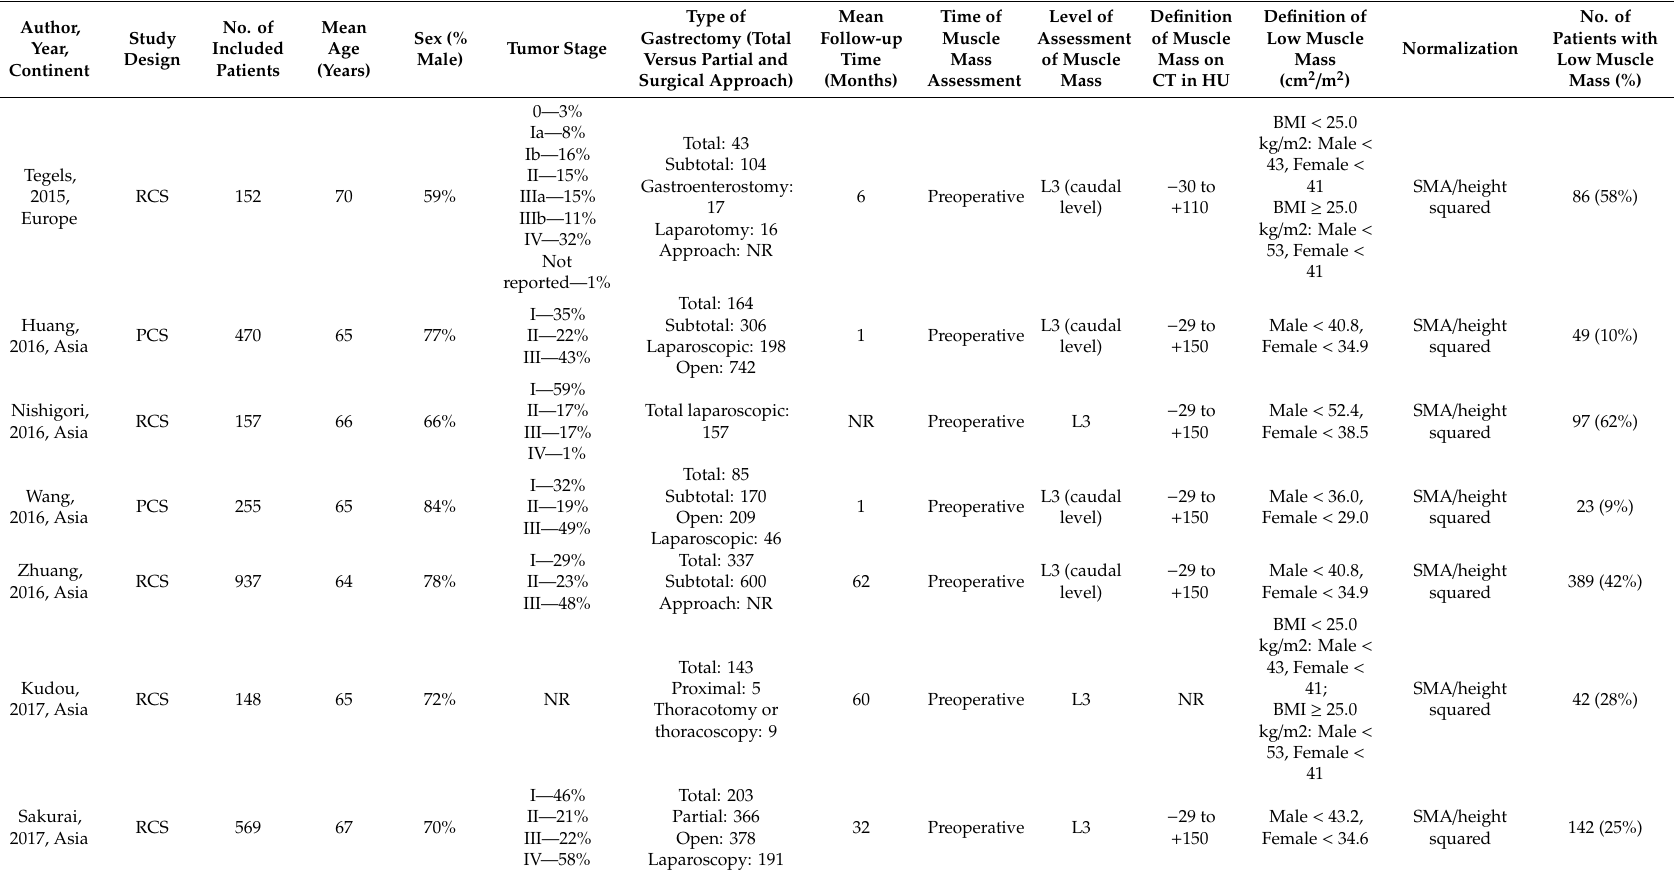
Table 1. Details of included